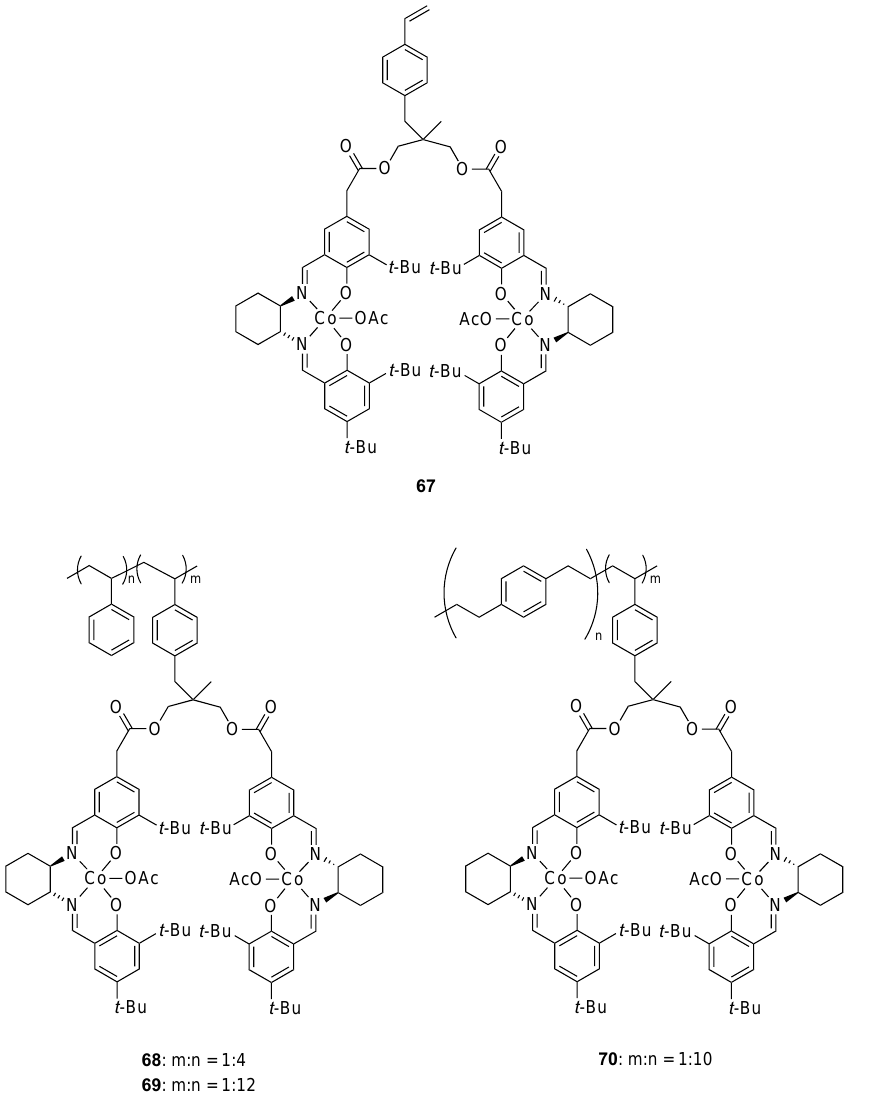
Figure 28. Dimeric Co–salen complex 67 and polymeric complexes 68 – 70 .